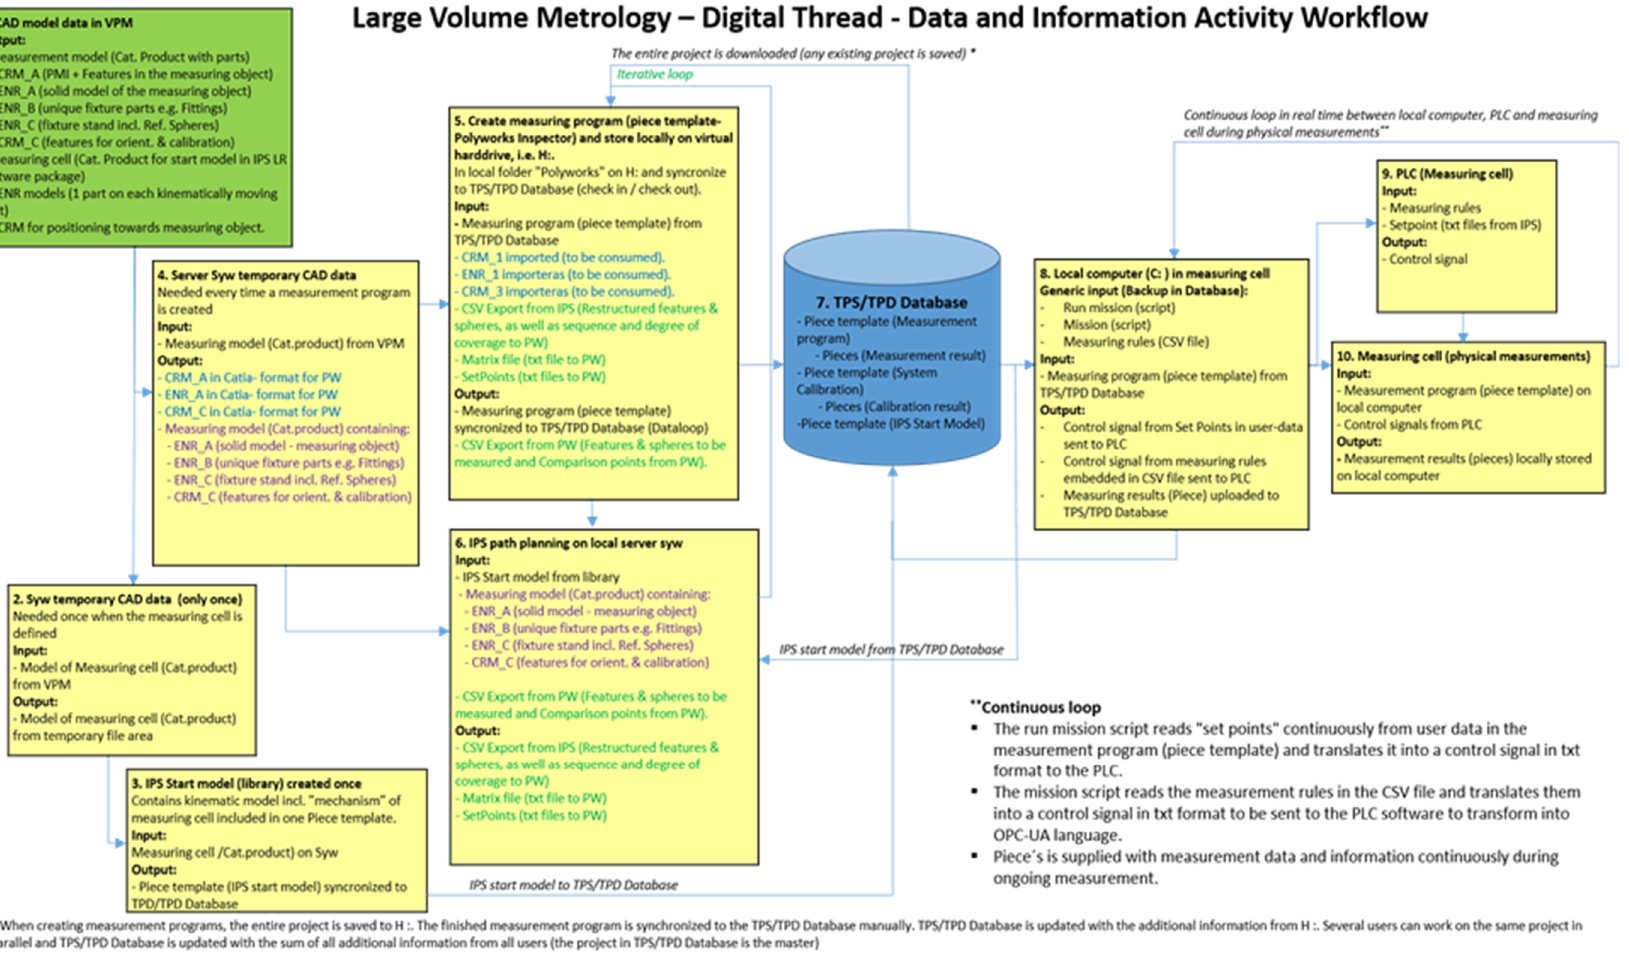
Figure 19. Digital thread and description of large volume metrology presented and illustrated through a data and information activity workflow. Exchange of different file formats are